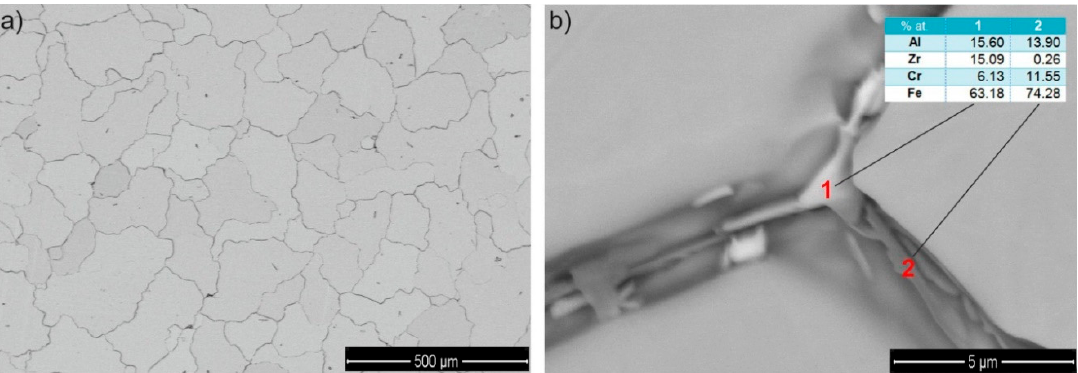
Figure 7. The initial microstructure of as-cast and homogenized Fe-22Al-5Cr alloy ( a ) and the chemical composition of precipitates at grain boundaries ( b ).